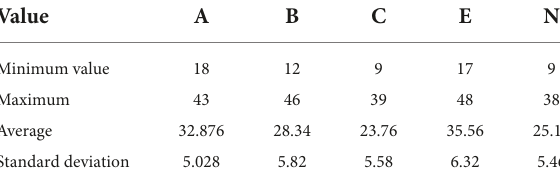
TABLE 1 Statistical information of five personality scores of